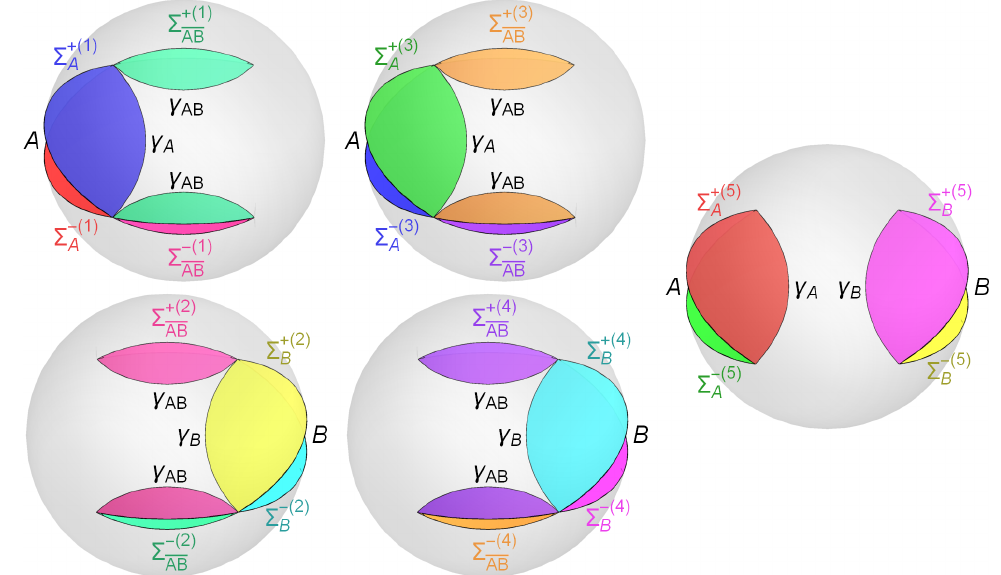
Figure 5 . The topology of a replica nonsymmetric saddle contributing to holographic Rényi negativity N k for k = 5 . The 5 copies are first cut along Σ A , Σ B , Σ Σ ± ( i ) , Σ ± ( i ) , and Σ ± ( i ) with the same color are glued together (cyclically along Σ A in copies 1 , 3 , A B AB 5 , anti-cyclically along Σ B in copies 2 , 4 , 5 , and pairwise along Σ